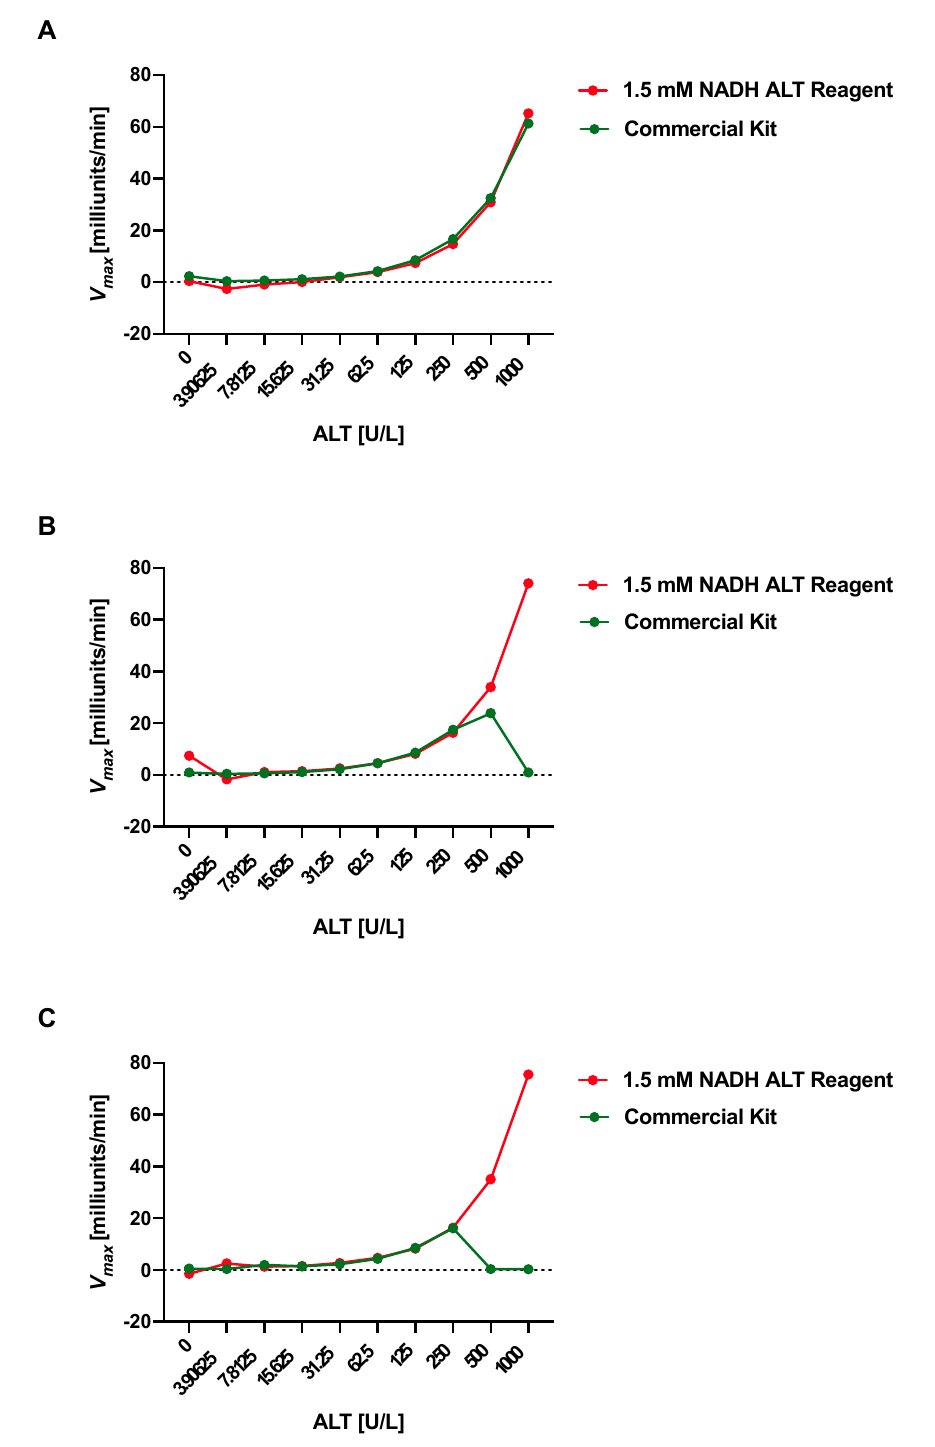
Figure 2. ALT reagent with high NADH concentration shows longer stability of standard curve than commercial kit. ALT reagent with high NADH concentration (1.5 mM, red) and ALT reagent from commercial kit (ALT Kinetic Assay, #A524-150, Teco Diagnostics, green). ( A ) First run. ( B ) Second run. ( C ) Third run. V max , maximum reaction velocity.